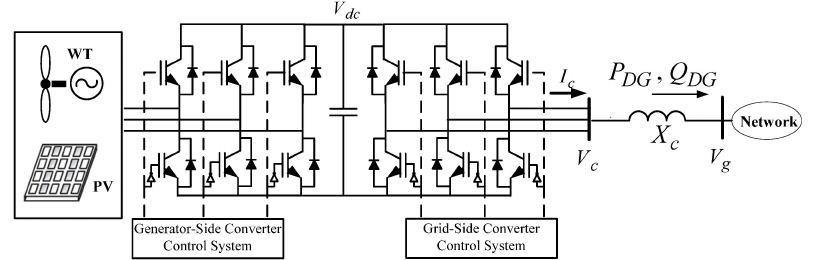
Figure 2. RES-DG with full power back to back converter.